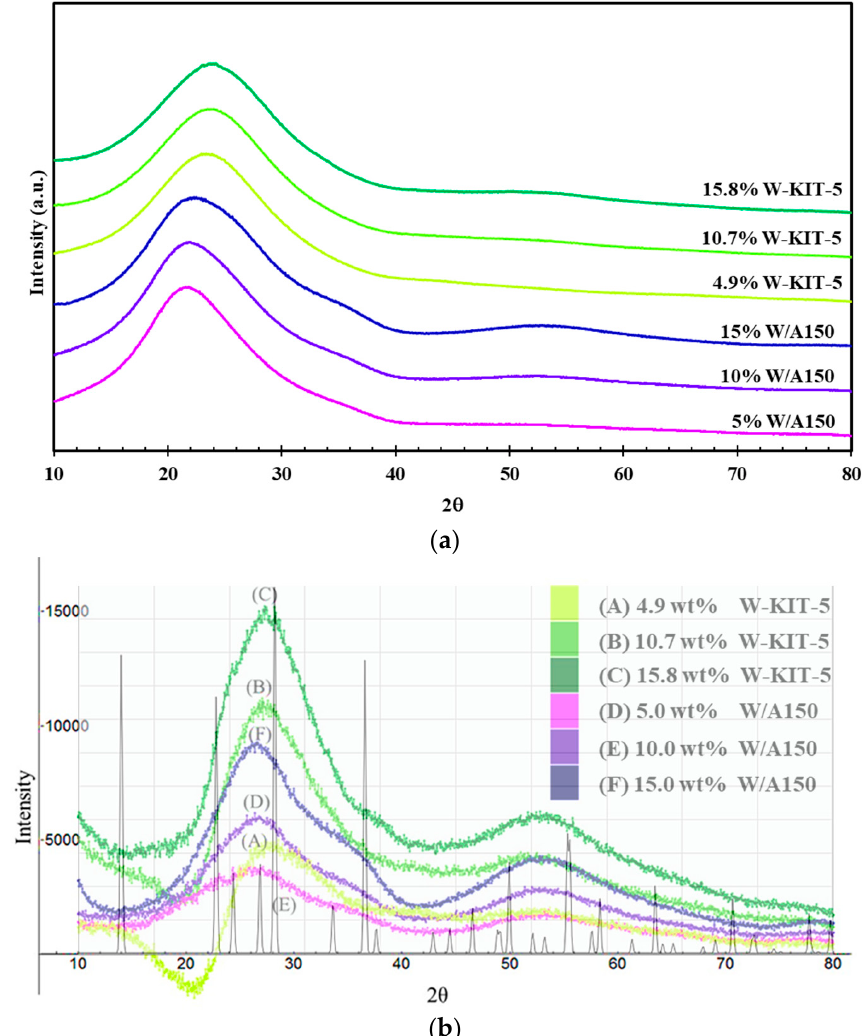
Figure 1. X-ray diffraction results of synthesized W/A150 and W-KIT-5 catalysts; ( a ) raw X-ray diffraction patterns; ( b ) background-subtracted patterns.